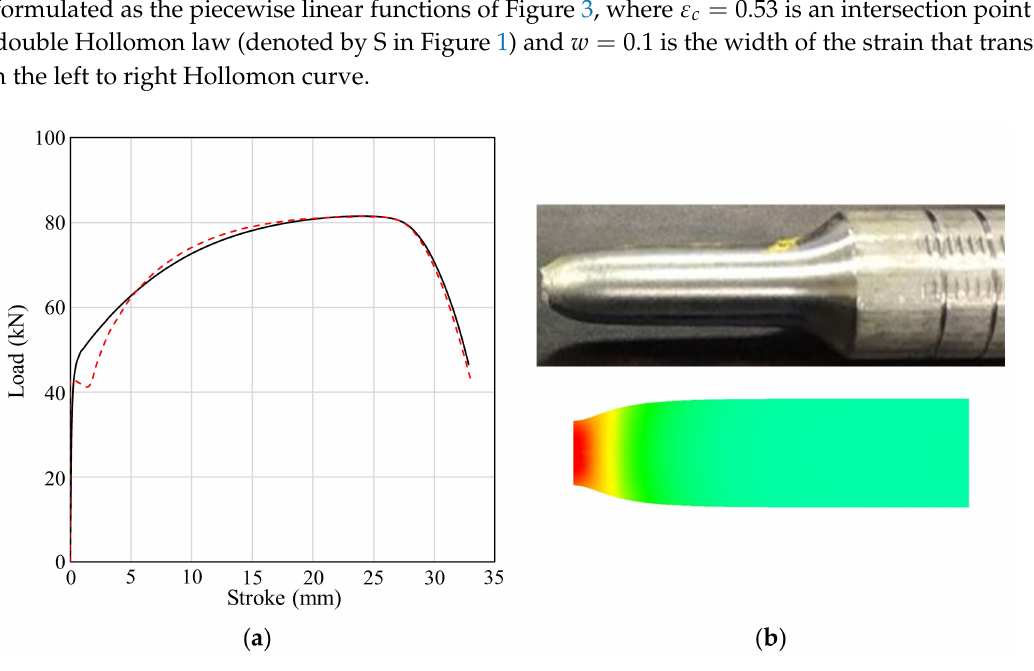
Figure 2. Comparison of the experimental and predicted tensile test results: ( a ) the tensile load–stroke; ( b ) the deformed